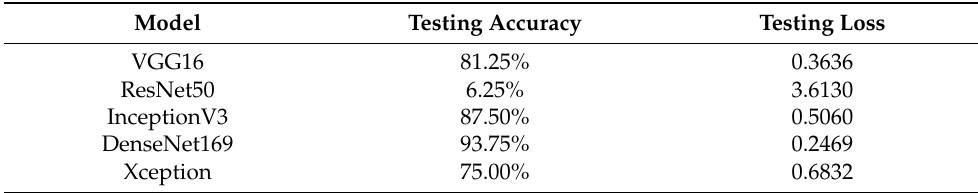
Table 7. Testing accuracies and testing loss when SLIC segmentation was used to create superpixels with a compactness (m) value of 10.